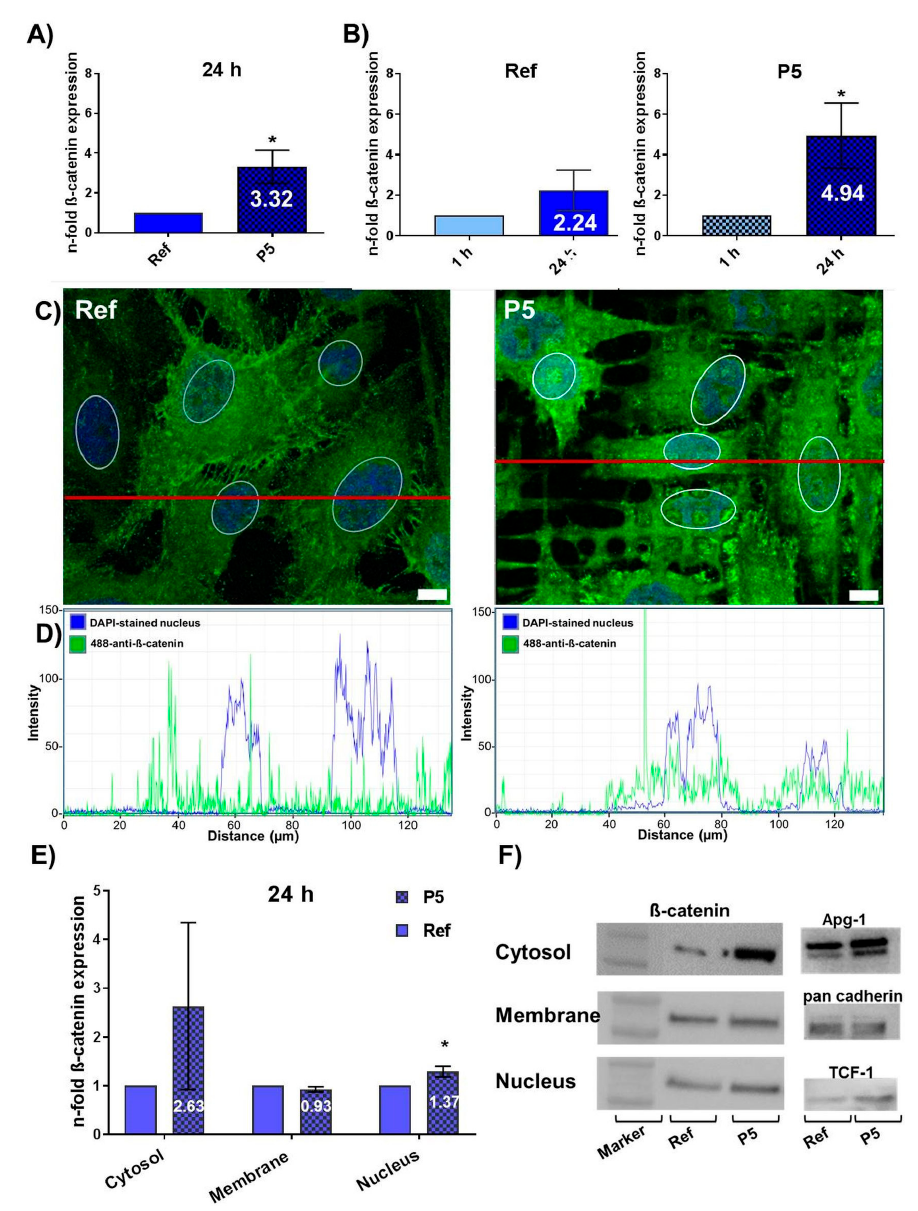
Figure 1. The β -catenin protein expression and localization in MG-63 osteoblasts on micro-pillars (P5). ( A ) Flow cytometric analysis of β -catenin total protein level in MG-63s after 24 h. Note that β -catenin was significantly increased in MG-63s on P5. (FACSCalibur, BD Biosciences; Ref values normalized to 1; mean ± s.e.m. of 4 independent experiments; Mann-Whitney U test; * p < 0.05). ( B ) Flow cytometric analysis of the time dependent β -catenin total protein expression after 1 h and 24 h on Ref and P5. Note that the expression of β -catenin on P5 was significantly increased after 24 h compared to 1 h, which indicated the accumulation of the protein. (FACSCalibur, BD Biosciences; 1 h values normalized to 1; mean ± s.e.m. of 4 independent experiments; Mann-Whitney U test; * p < 0.05). ( C ) Immunofluorescence of β -catenin in MG-63s on P5 compared with unstructured Ref after 24 h (green: Alexa Fluor ® 488-anti- β -catenin, blue: nucleus, DAPI (4 ′ ,6-diamidino-2-phenylindole); LSM 780, Carl